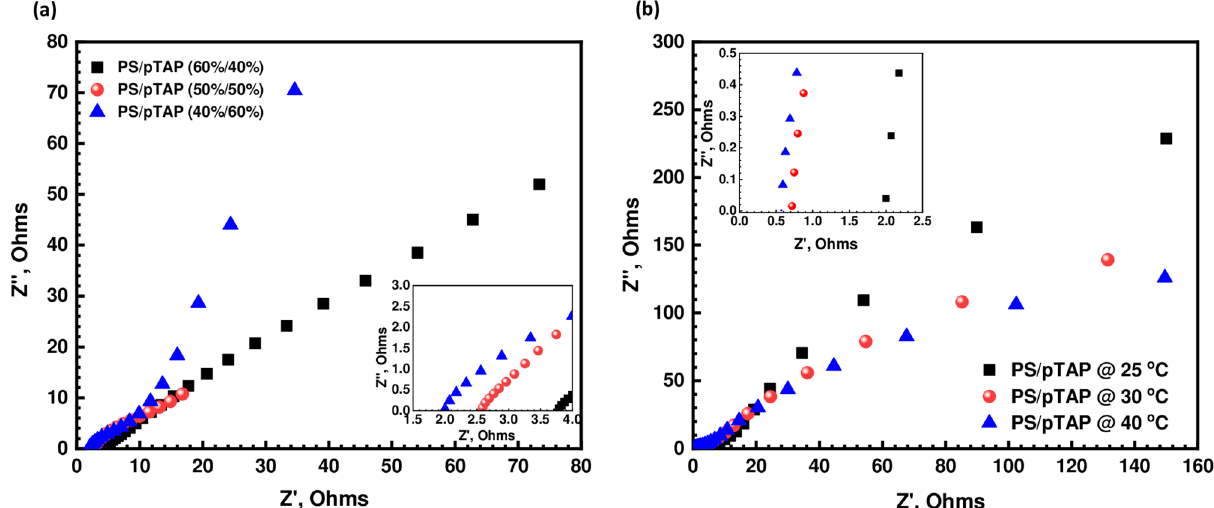
Figure 3. (a) Nyquist plots of PS/pTAP composite membranes with various weight loadings. (b) Nyquist plot for PS/pTAP (40%/60%) composite membrane with respect to temperature.